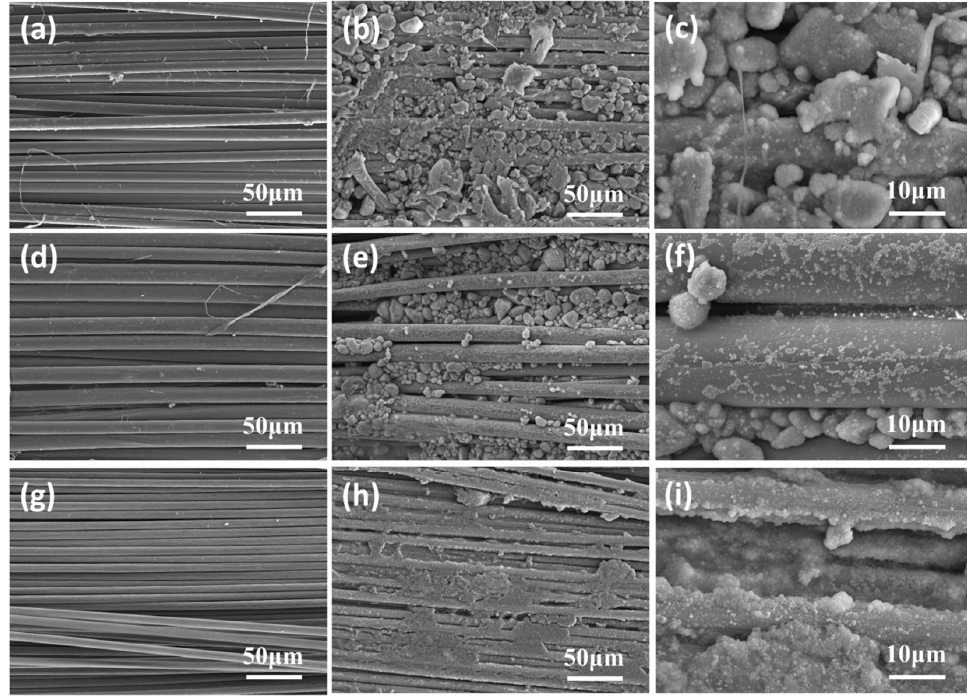
Figure 7. SEM images of neat and STF-treated fabrics. ( a ) Neat aramid fabric (1000 × ); ( b ) STF/aramid (1000 × ); ( c ) STF/aramid (5000 × ); ( d ) neat PBO fabric (1000 × ); ( e ) STF/PBO (1000 × ); ( f ) STF/PBO (5000 × ); ( g ) neat C fabric (1000 × ); ( h ) STF/C (1000 × ); ( i ) STF/C (5000 × ).